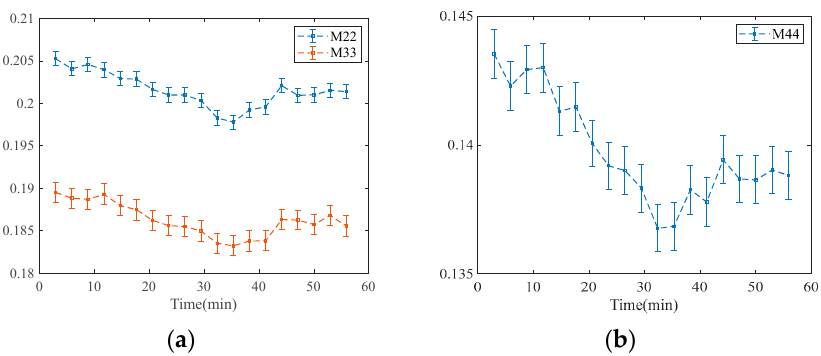
Figure 3. Average values and standard deviations of the MM diagonal elements of human skin: ( a ) M22, M33 and ( b ) M44 . The horizontal axes represent the time after the application of 10% glycerin.